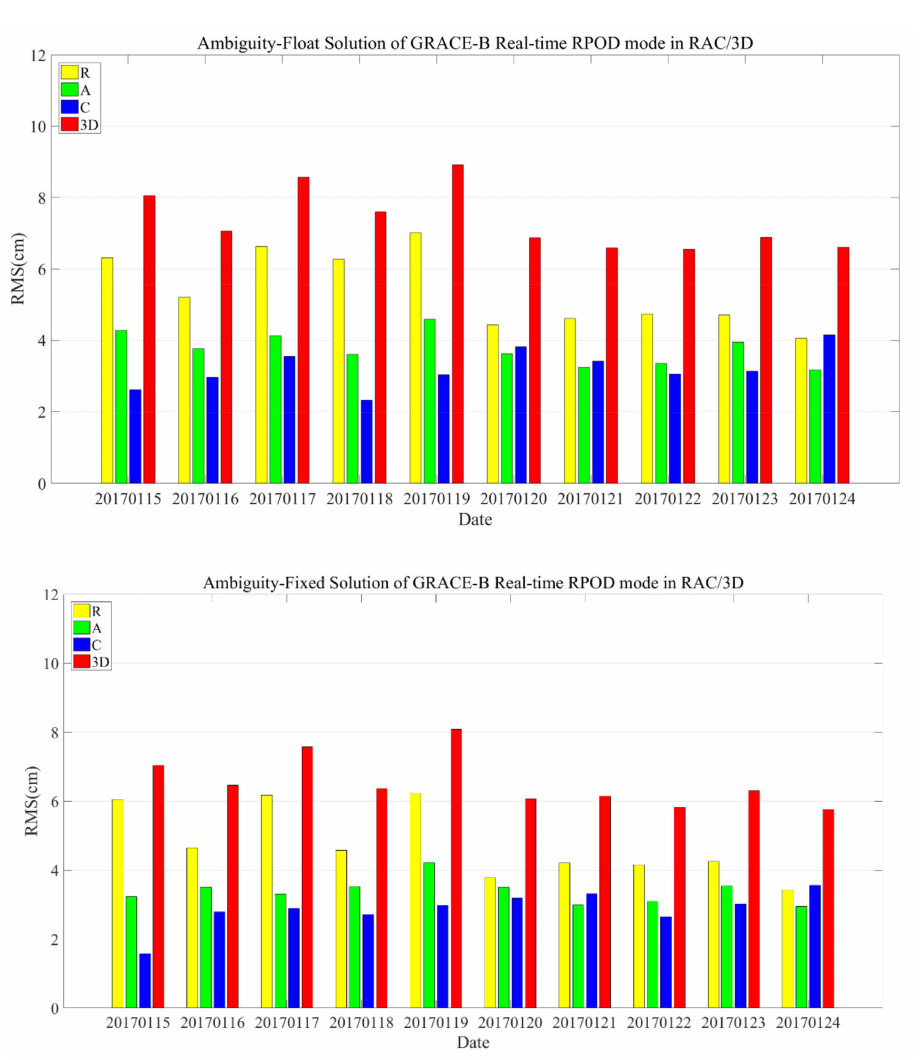
Figure 9. The accuracy (RMS) of real-time RPOD ambiguity-float ( upper ) and ambiguity-fixed ( bottom ) solution for GRACE-B. Table 5. The GRACE-B ambiguity-fixed ratio and RMS of real-time RPOD in R (radial), A (along- track), and C(cross-track) directions and 3D-RMS (total position error) with different solution